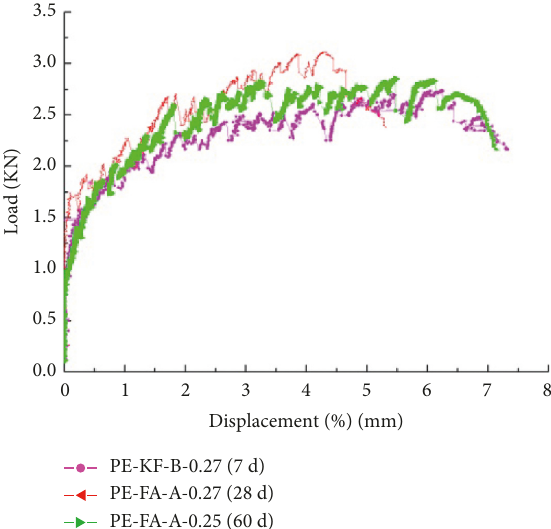
Figure 11: The uniaxial tensile load-displacement curve of PE-